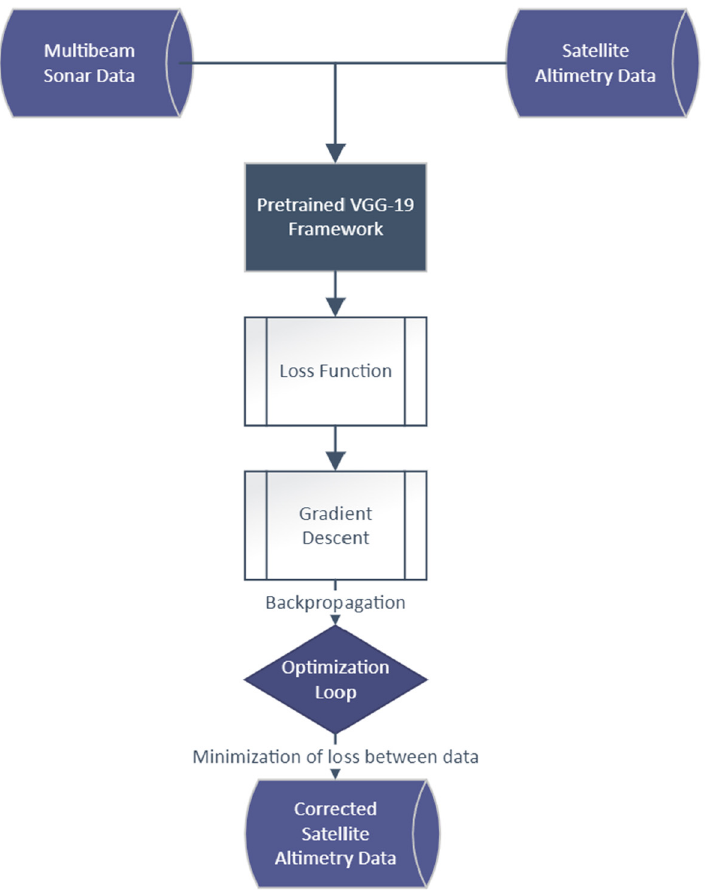
Figure 1. Main structure of the proposed